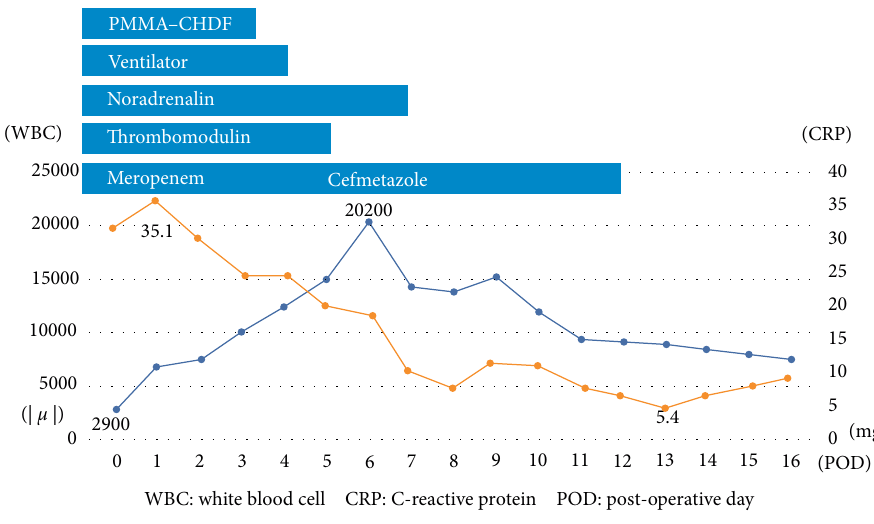
Figure 2: Clinical course of this patient. Table 1: Clinical characteristics of the